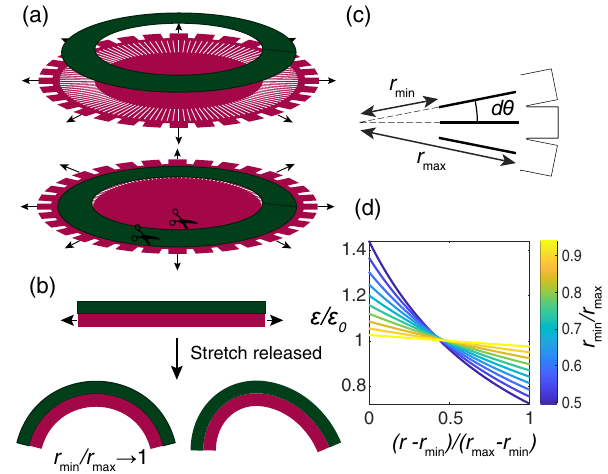
FIG. 5. Stretched latex bilayers. (a) A latex sheet is stretched radially by a predetermined factor. The sheet is then glued to an unstretched sheet made of latex or polypropylene. The radial cuts release the hoop stress resulting from the Poisson effect, inducing a quasiradial stretch. (b) When cut into a curved ribbon and thus released, a radial reference curvature is imposed to the structure. This curvature is, however, not exactly constant. Depending on the size of the radial cuts, and more specifically on the ratio r =r (c), the radial strain, and thus the target curvature, vary min max as a function of the radial coordinate r (d). This effect is, however, neglected in our